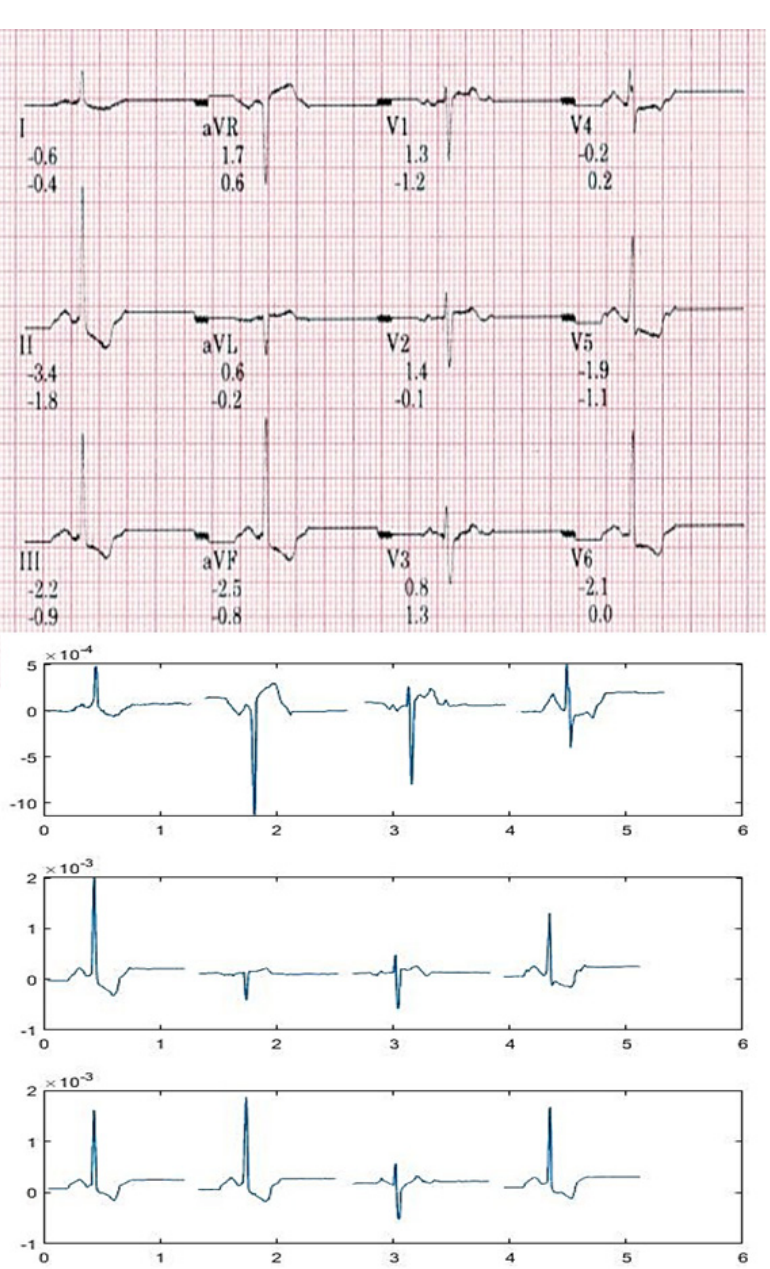
Figure 7. Twelve-lead ECG data comparison between the original data and extracted data.